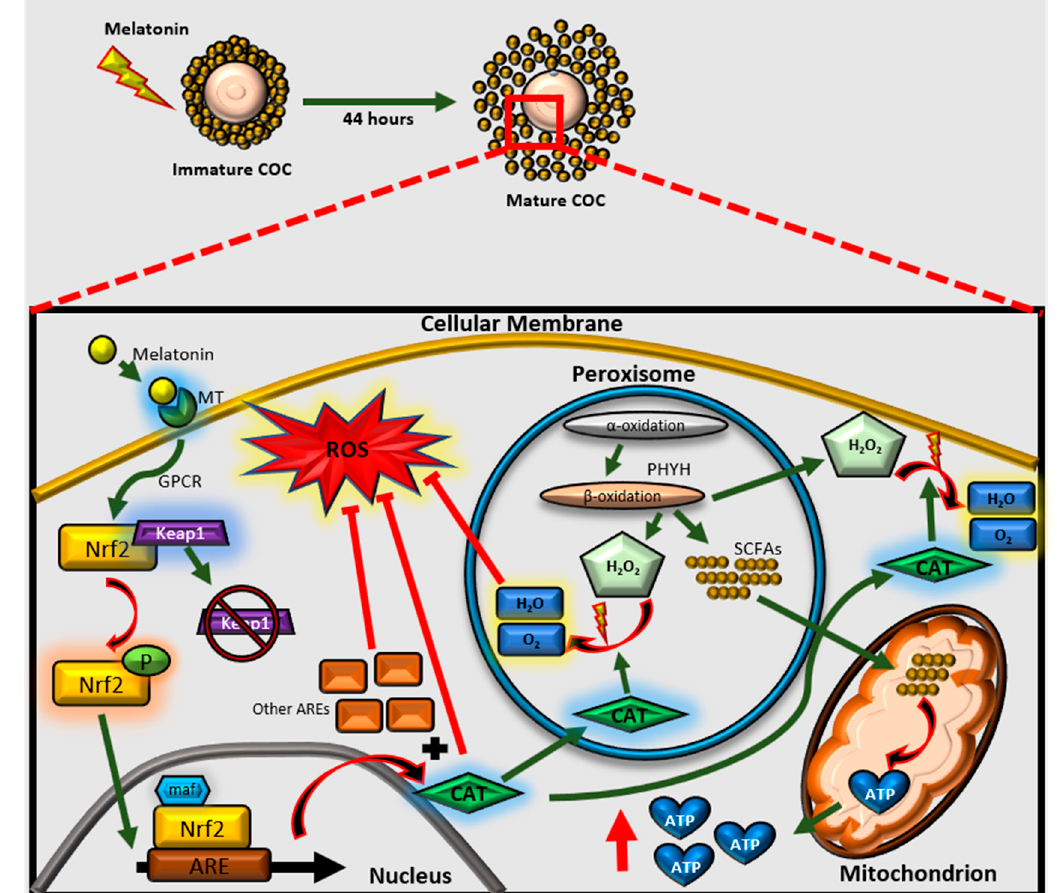
Figure 8. A schematic illustration of the cross-talk between Nrf2 signaling and peroxisomes activated by melatonin in porcine COCs. When melatonin binds to melatonin receptor 2, a series of cascades is activated via the GPCRs. Nrf2 is subsequently activated by the detachment of Keap1, which is later targeted for degradation. Activated Nrf2 is translocated to the nucleus, and transcription is initiated in conjunction with maf. Catalase is produced that prevents ROS accumulation, hydrolyzes H 2 O 2 , and also work in peroxisomes. Through α - and β - oxidation, Short-chained fatty acids (SCFAs) and H 2 O 2 are produced in the peroxisome. The SCFAs are transferred to mitochondria for energy production. In addition, catalases are also stored in the peroxisome to hydrolyze H 2 O 2 generated during peroxisomal activities. MT: melatonin receptor.